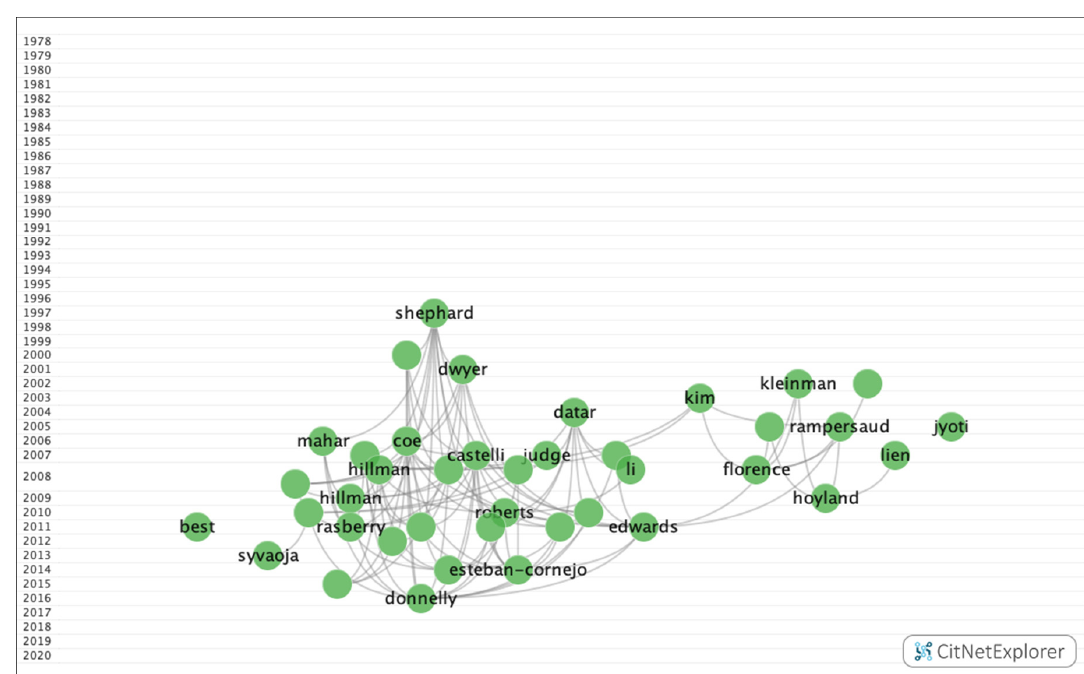
Figure 8. Group 2 citation network.